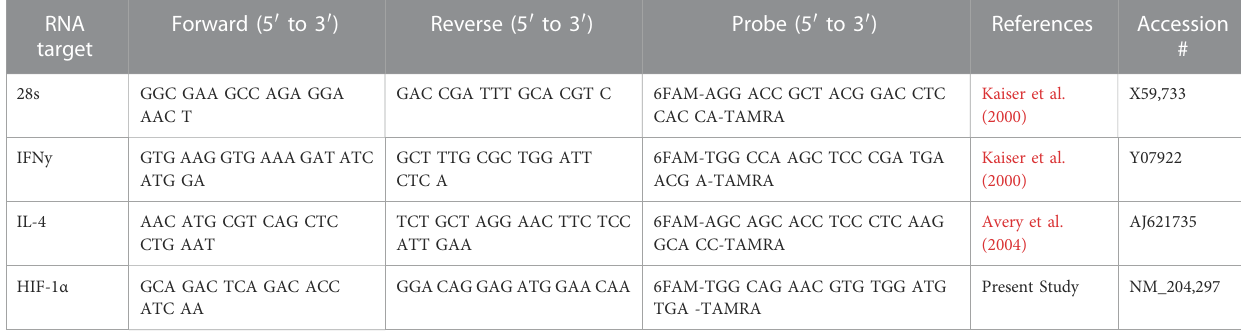
TABLE 1 Primer and probe sequences for qRT PCR. RNA